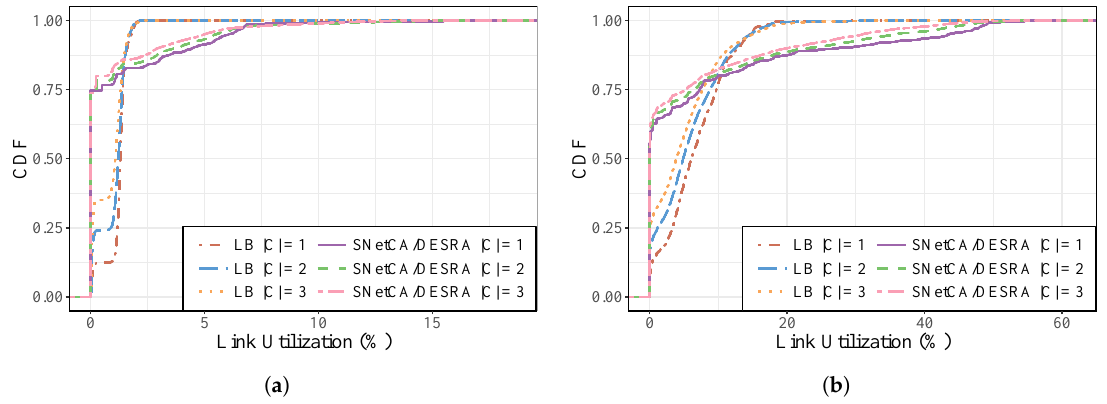
Figure 12. Cumulative distribution function of link utilization varying the amount of controllers in the: ( a ) New York topology; and ( b ) Geant topology.